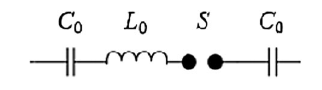
FIG. 2. Simplified basic discharge